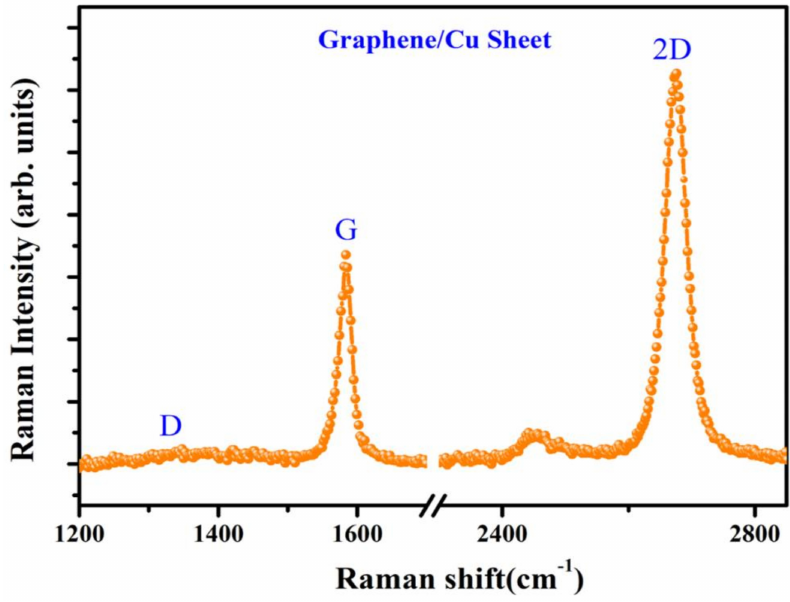
Figure 2. Raman spectrum of the graphene grown on Cu sheet after a background subtraction and normalization